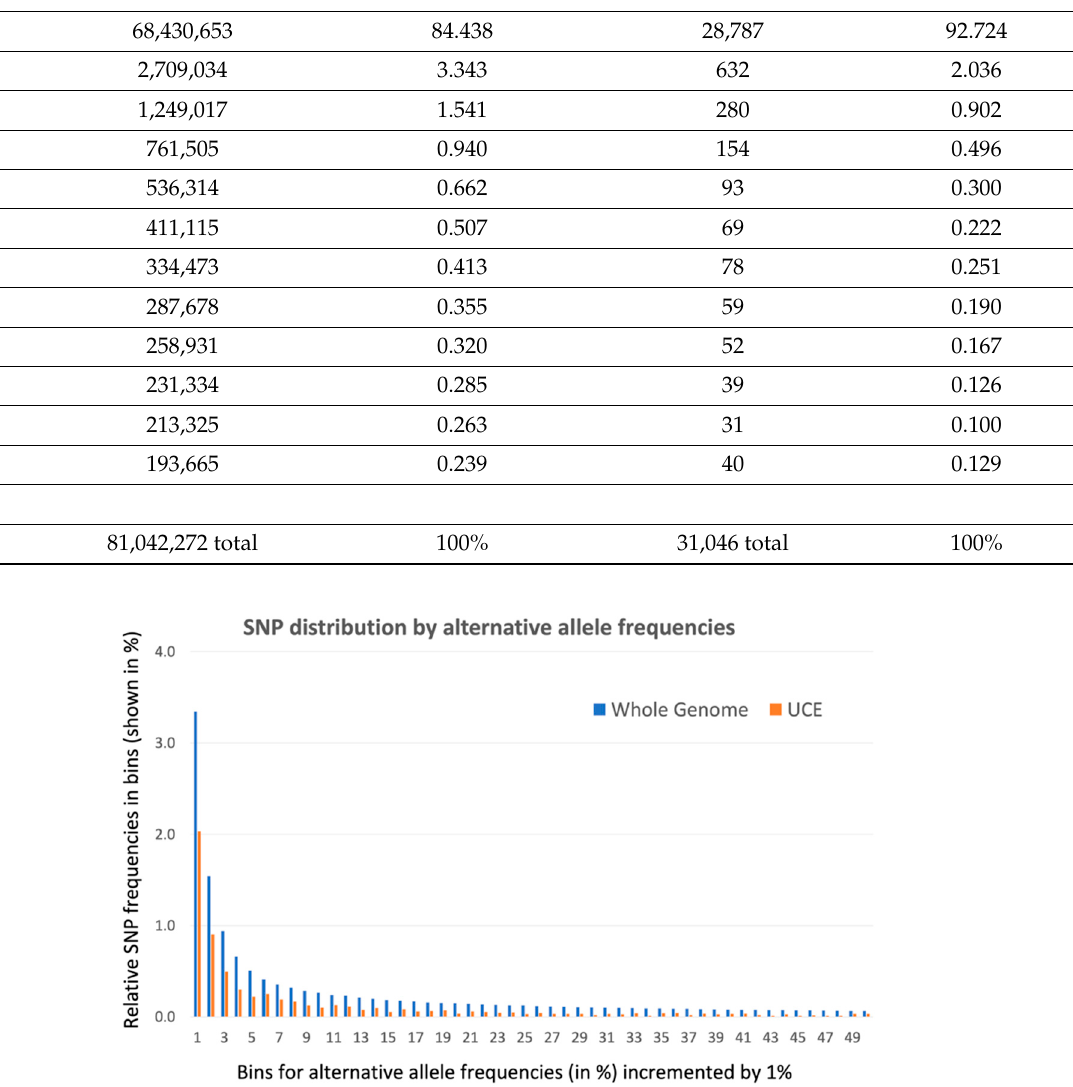
Figure 1. Distribution of SNP relative frequencies by their alternative allele abundance inside UCNEs and the whole genome. This is a graphical representation of data from Table 1 for the second up to fiftieth bins for columns 3 and 5. Starting from the second bin, the relative frequency of SNPs inside the whole genome is always higher than inside UCNE sequences, and the difference becomes more dramatic with the increase of alternative allele frequency (bin consecutive order).